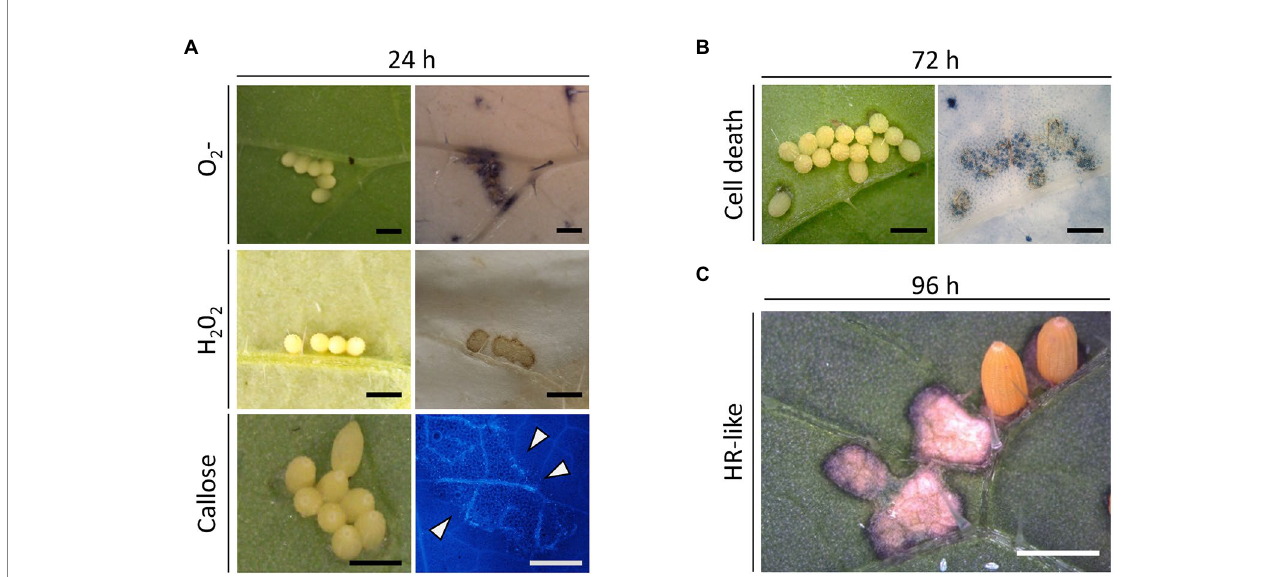
FIGURE 1 Plant immunity responses induced in Brassica nigra by Pieris brassicae eggs ( Bn ). (A) B. nigra leaf 24 h after oviposition with accumulation of O 2• − (NBT staining), H 2 O 2 (DAB staining) and callose deposition (aniline blue staining). (B) B. nigra leaf 72 h after oviposition showing cell death (trypan blue staining). (C) Fully developed HR-like cell death that is macroscopically visible at 96 h after oviposition. A few eggs were removed from the clutch to show the cell death underneath. Stainings were repeated multiple times with similar results. Scale bars = 1